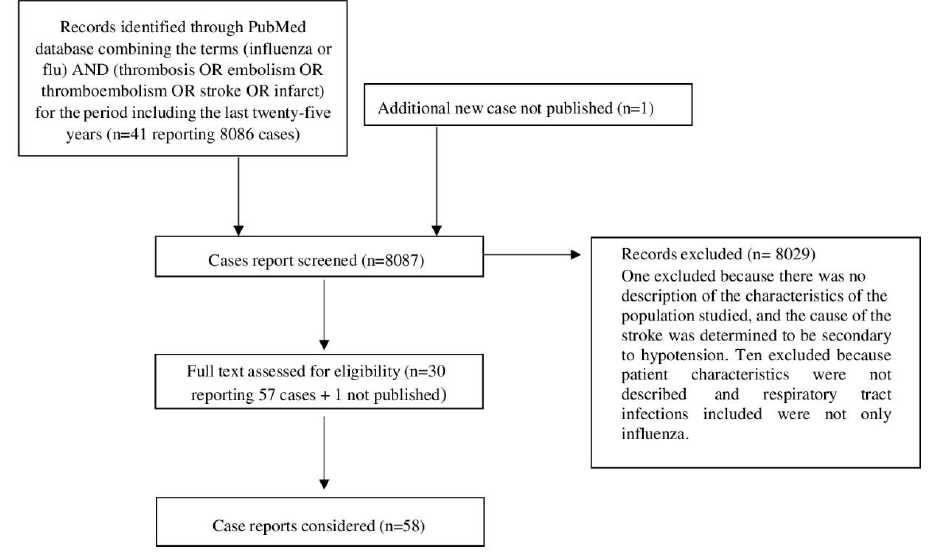
Figure 1. Flow chart summarizing the literature research approach.